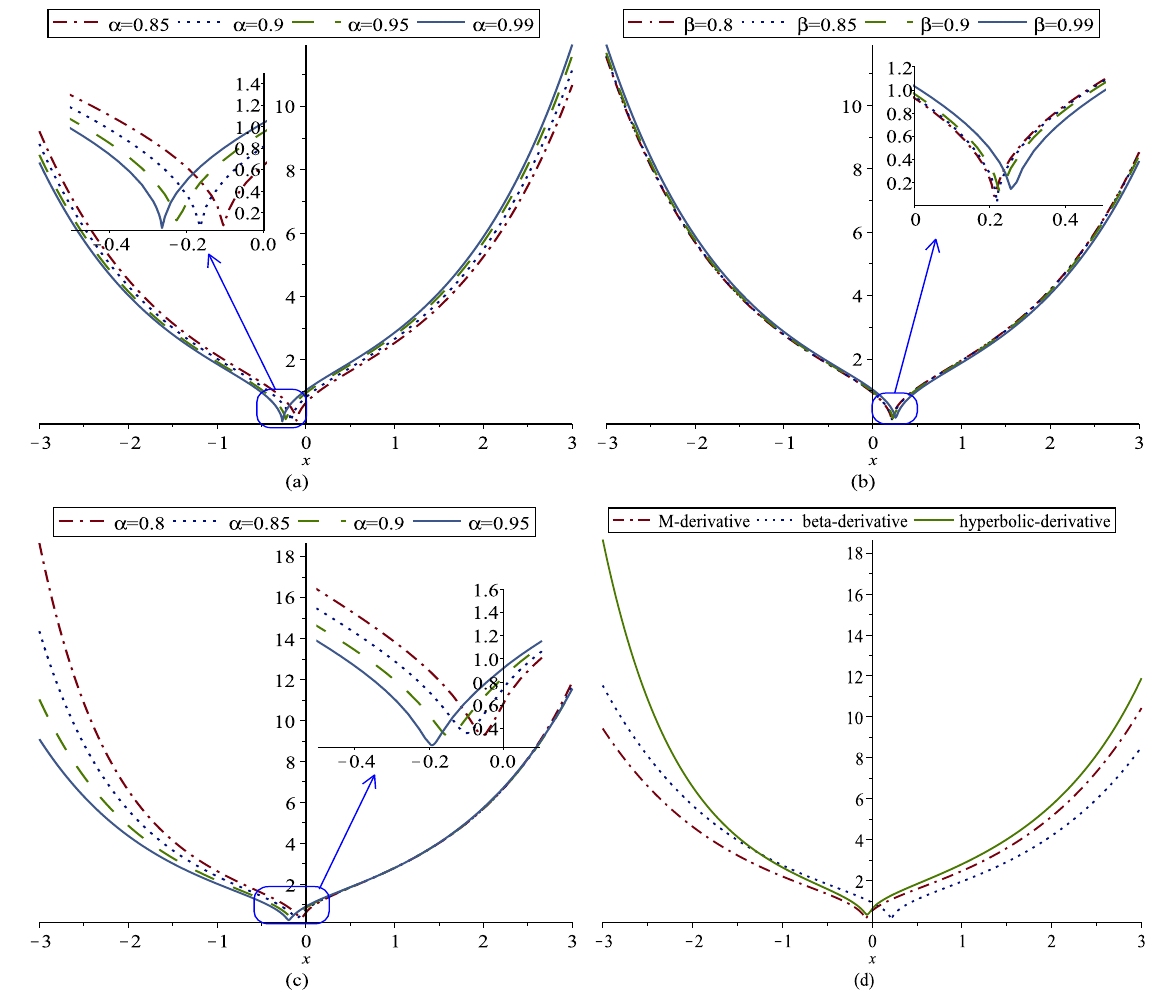
√ 3 2, m = 3, and ( a ) β = 0.9, 2